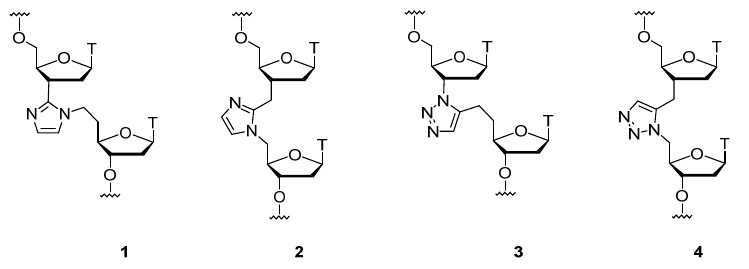
Figure 4. Thymidine dinucleoside analogues with imidazole and triazole modified backbones.